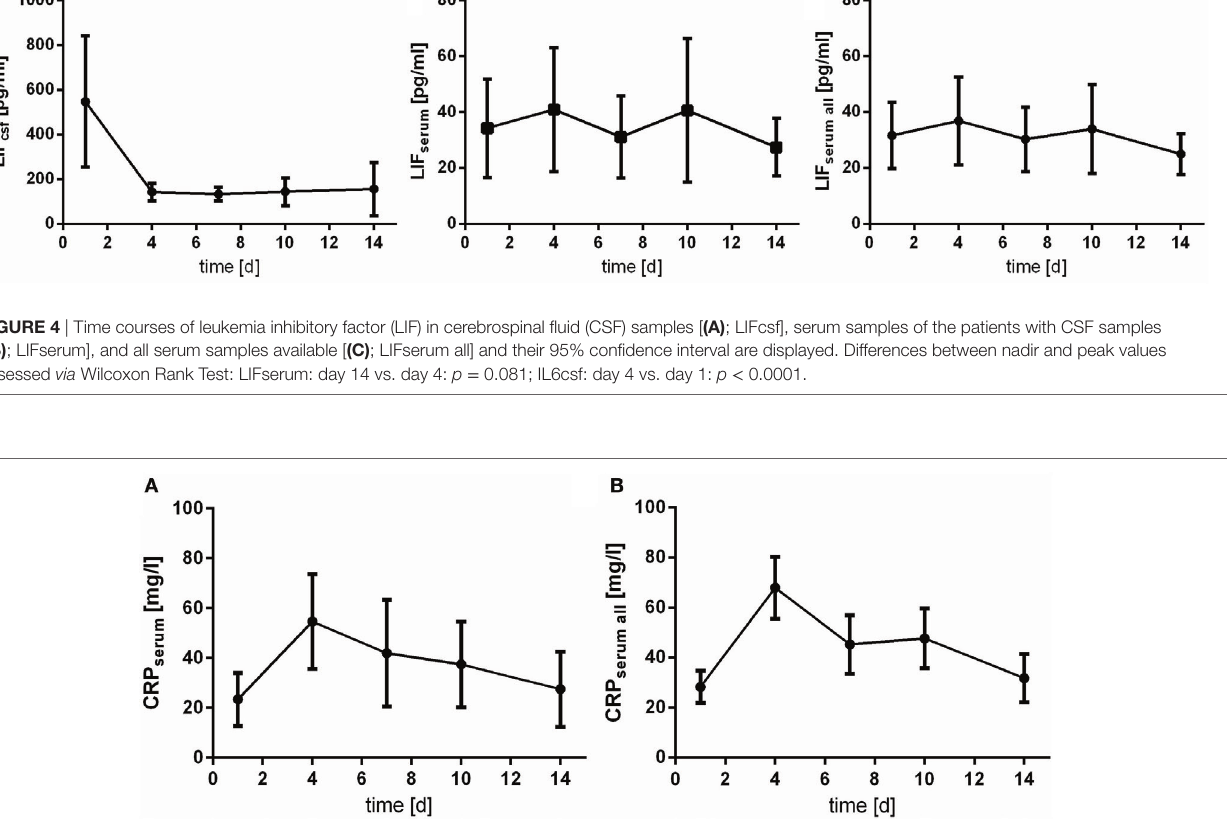
courses of inflammatory Parameters related to Fisher scale score Courses of inflammatory parameters additionally were compared related to Fisher scale score. Grading according to Fisher scale